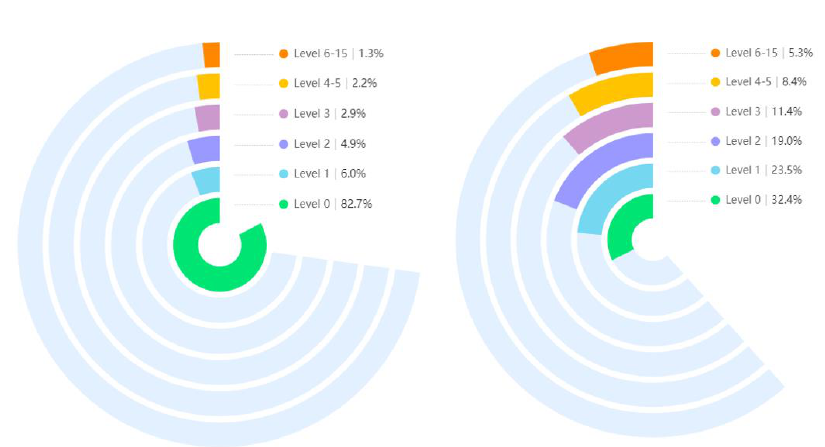
Figure 7. Comparison of data volumes for the six pain levels after